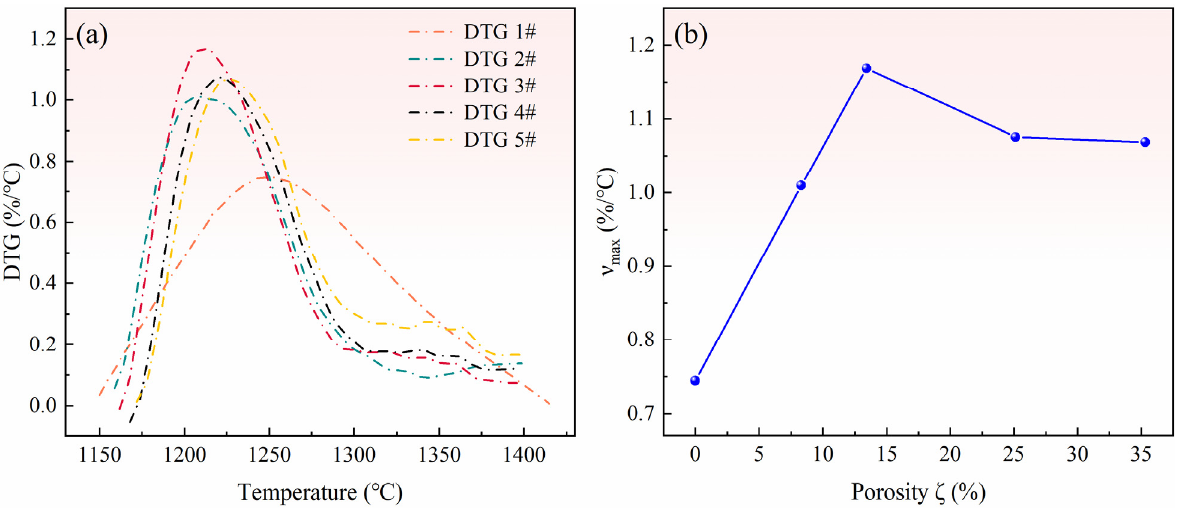
Figure 11. ( a ) Reduction rates of pellets with different porosities. ( b ) Relationship between pellet porosity and maximum reduction rate.